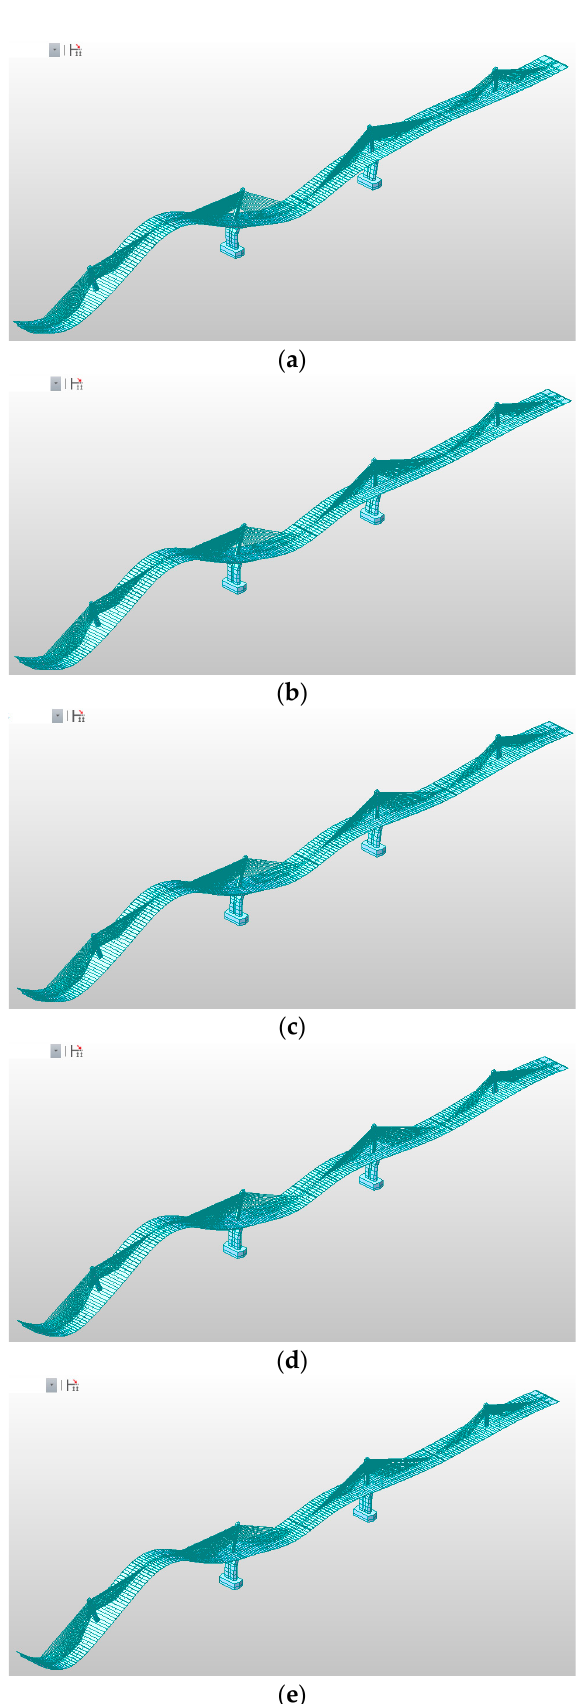
Figure 10. Modal mode diagram. ( a ) Group 1; ( b ) Group 2; ( c ) Group 3; ( d ) Group 4; ( e ) Group